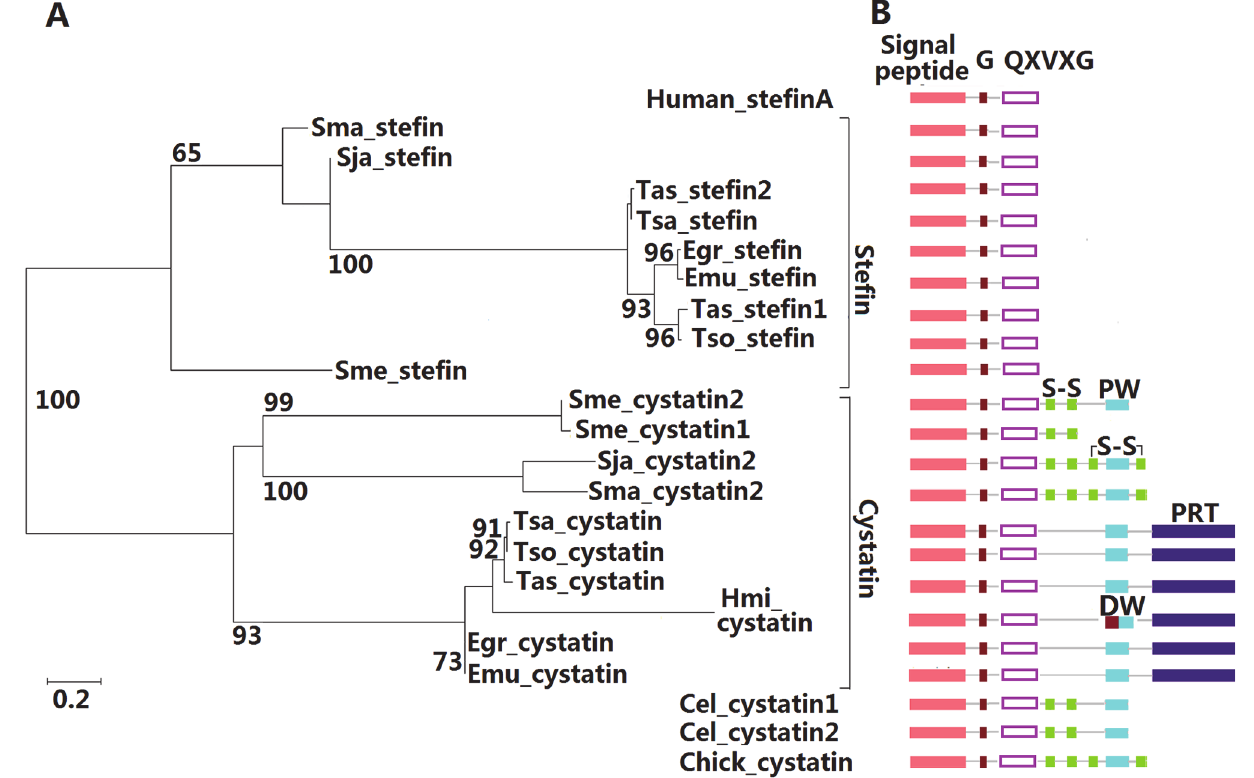
Fig 3. Phylogenetic analysis (A) and architecture (B) of platyhelminth cystatin superfamily. (A) Phylogenetic tree derived from the alignment of complete predicted proteins sequences. Nodes with confidence values greater than 60% are indicated based on maximum likelihood (ML). Subfamilies are indicated at the right. (B) The fragment from Gly (G) to Cys (C) or Pro-Trp (PW) residue represent predicted cystatin-like domain. The RPT represent tandem repeated domains. Disulfide bonds between conserved cysteines are denoted. The typical motifs for Stefin (human stefin A) and cystatin (chicken cystatin) subfamily members are represented on top and below, respectively. The first three letters: (Egr) E . granulosus ; (Emu) E . multilocularis ; (Sja) S . japonicum ; (Sma) S . mansoni ; (Sme) S . mediterranea ; (Tas) T . asiatica ; (Tsa) T . saginata ; (Tso) T . solium ; (Hmi) H . microstoma ; (Cel) C . Elegans .